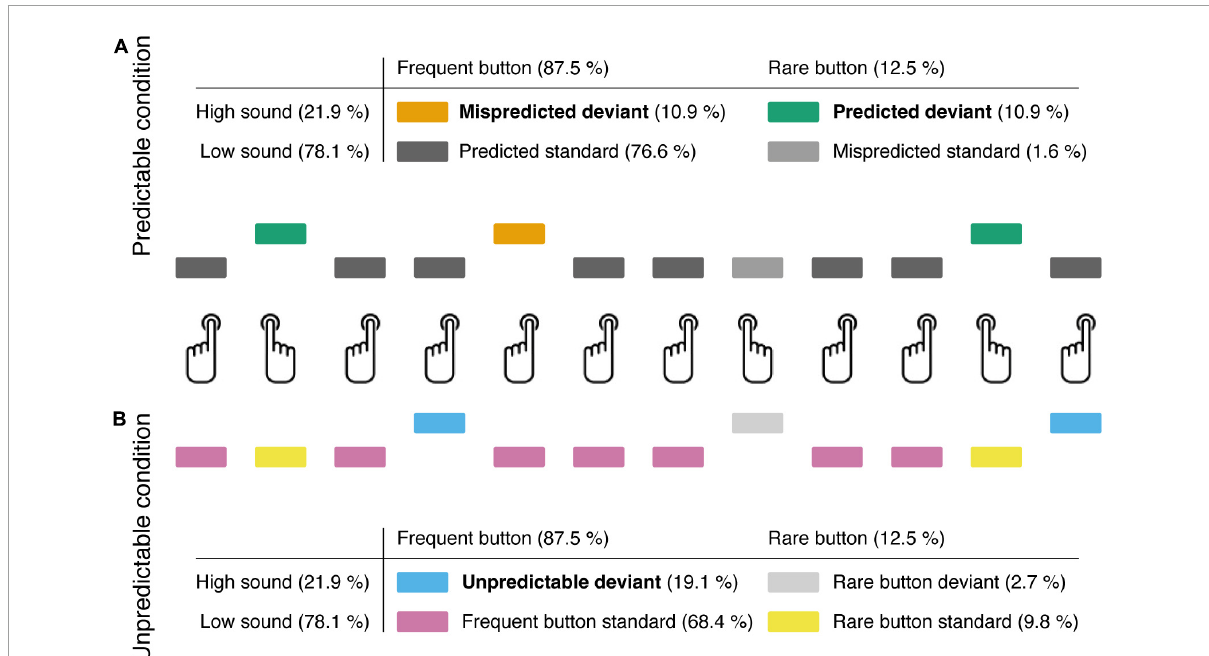
FIGURE1 Participants pressed one button frequently and the other button rarely. Button presses generated a frequent low pitch (“standard”) or a rare high pitch (“deviant”) tone. (A) In the predictable condition, participants were instructed to generate standard and deviant sounds via the respective buttons. In addition to self-produced “predicted deviants,” the frequently pressed button occasionally elicited a “mispredicted deviant” (instead of a standard). (B) In the unpredictable condition, the type of button-press (frequent, rare) and the type of sound (standard, deviant) were unrelated, so that “unpredictable deviants” were